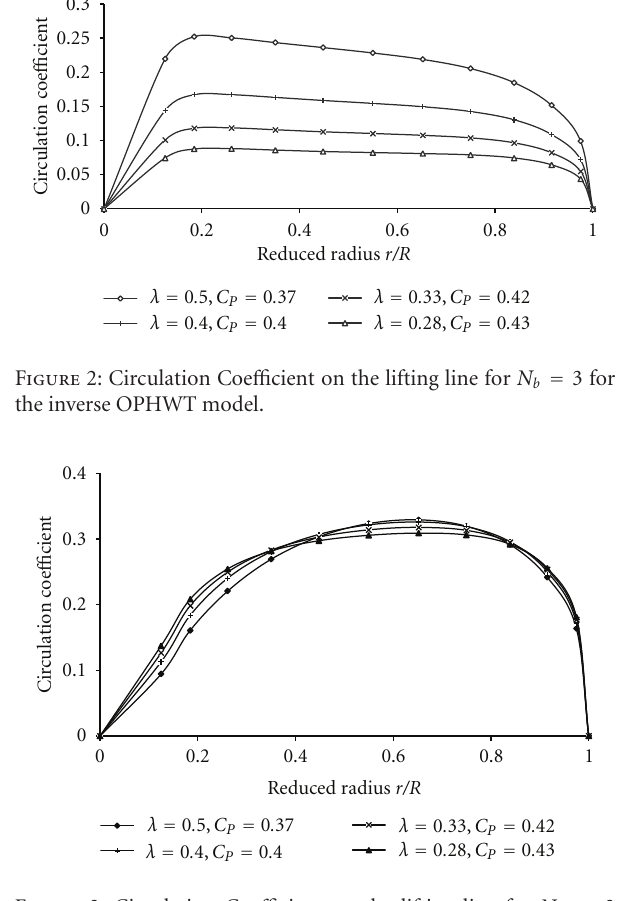
Figure 3: Circulation Coe ffi cient on the lifting line for N b = 3 obtained by the kinetic energy model.